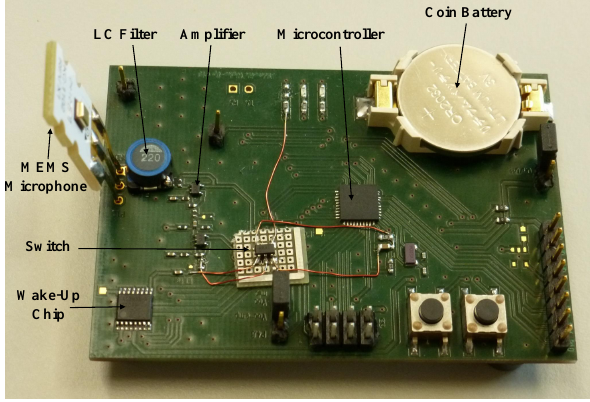
Figure 3. A prototype of a wake-up receiver